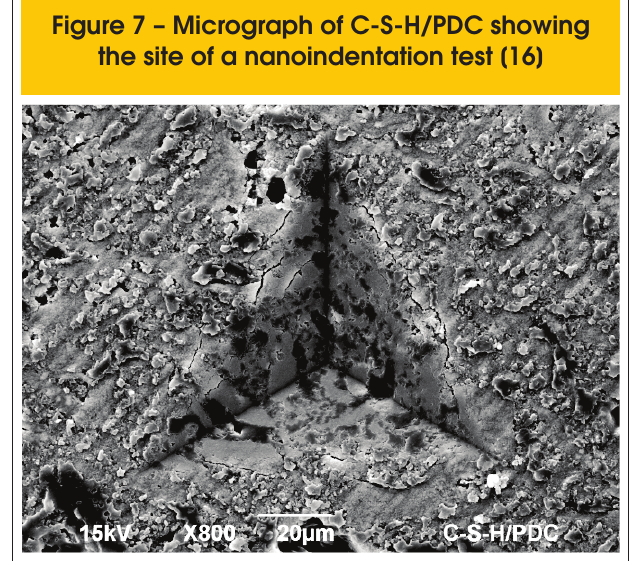
Figure 7 – Micrograph of C-S-H/PDC showing the site of a nanoindentation test